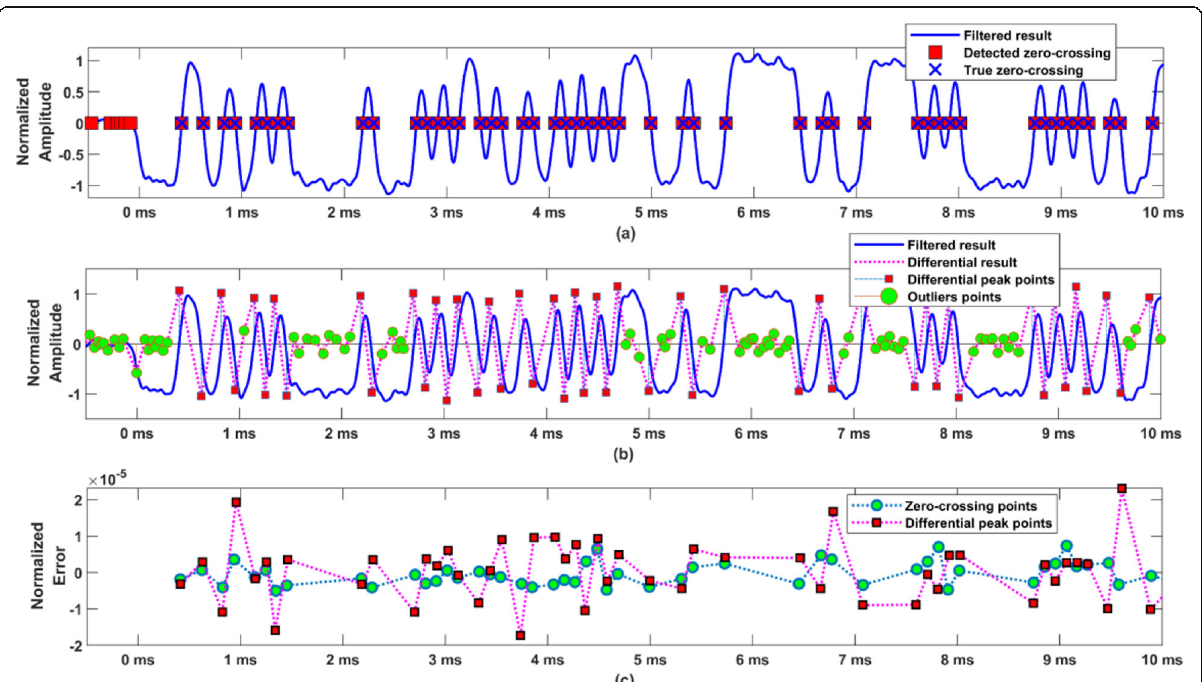
Fig. 6 Timestamp detection ( a ), zero-crossing detection ( b ), and differential peak detection ( c ). Error distribution: a The detection results of the zero-crossing method. b The detection results of the differential peak method. Both the x -axes denote the time in milliseconds and the y -axes are the normalized amplitude. c The comparison of the two methods. The x -axis denotes the time in milliseconds and the y -axis is the normalized error